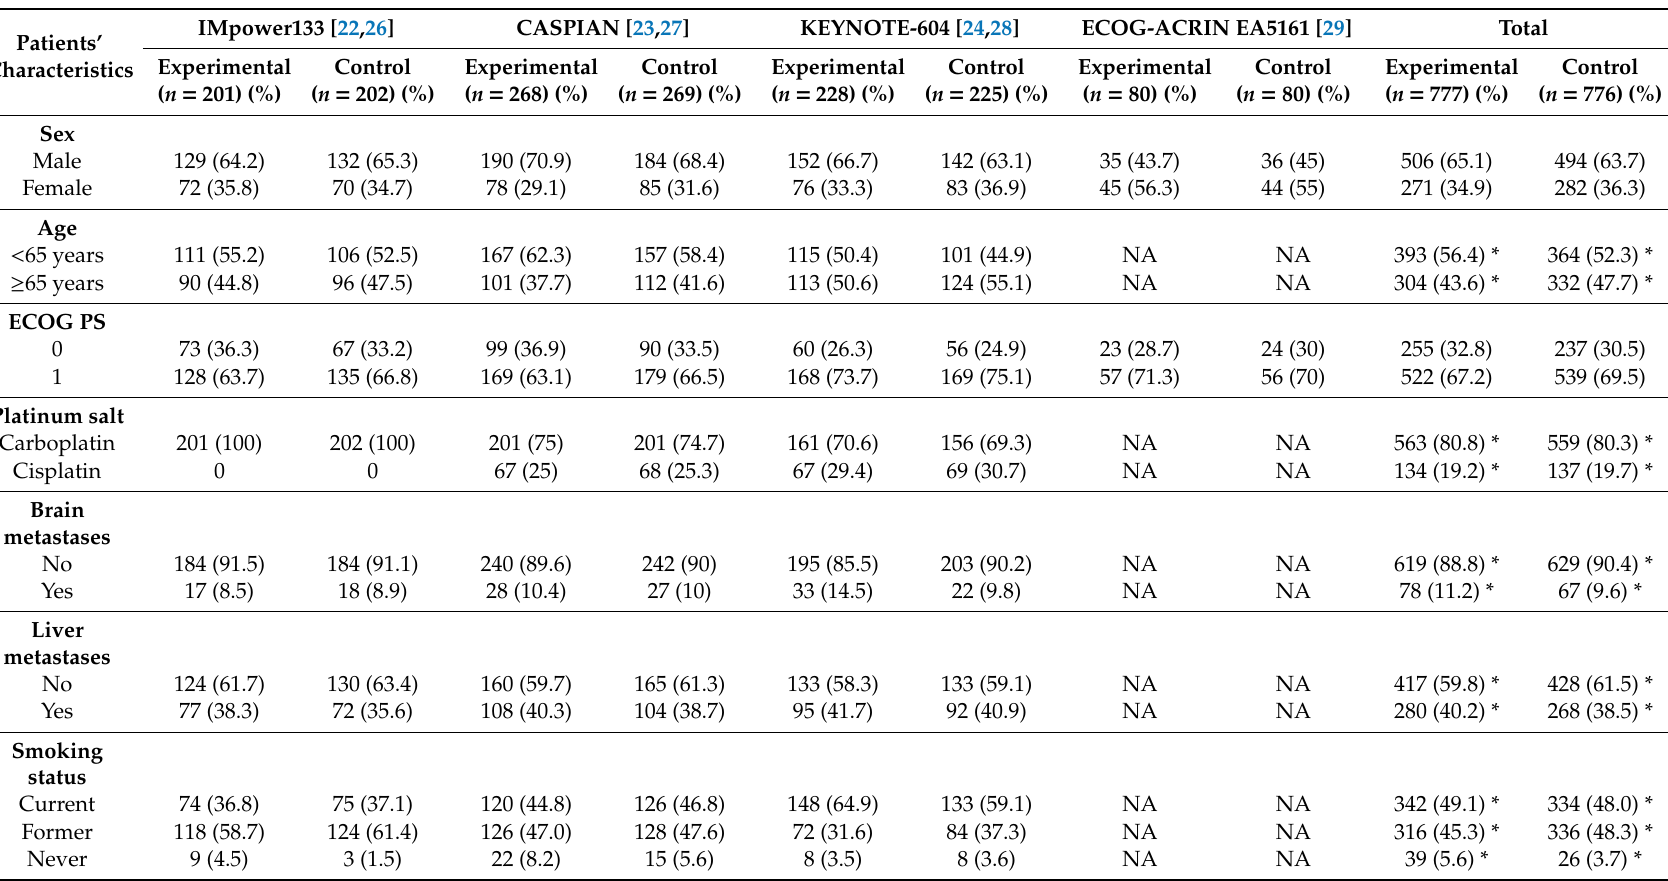
Table 2. Patients’ characteristics across trials and as gathered in the